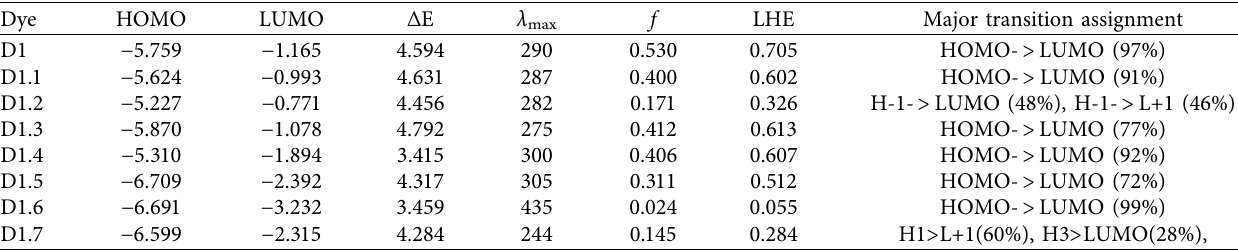
Table 3: The calculated HOMO (eV), LUMO (eV), bandgap ( ∆ E/eV), absorption wavelengths ( λ harvesting efficiencies (LHE), and electronic transition assignments of the gas-phase D1-D1.7 derivatives using B3LYP/6-311++G ∗∗ . Dye